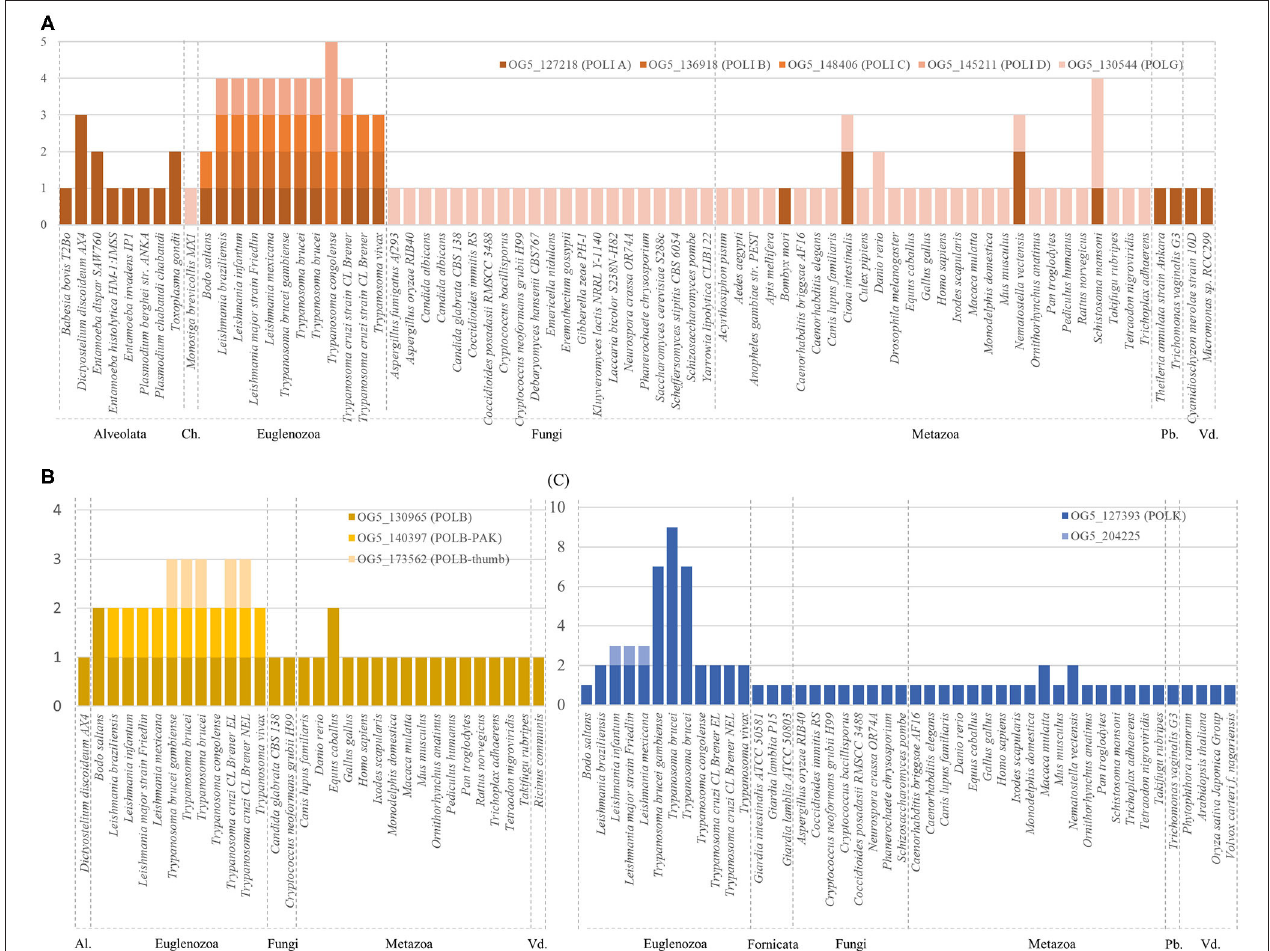
FIGURE 1 | Representation of number of genes (y axe) of DNA polymerases orthologs groups retrieved from OrthoMCL (see Supplementary Table 2 ). (A) Genes related to mitochondrial DNA polymerases (POLI A-D; POLG) from the indicated orthologs groups. (B) Genes related to POLB from the indicated orthologs groups. (C) Genes related to POLK from the indicated orthologs groups. Species are grouped by phylum . ID from represented genes are available at Supplementary Material . Ch, Choanoflagellata; Pb, Parabasalids; Vd, Viridiplantae; Al,